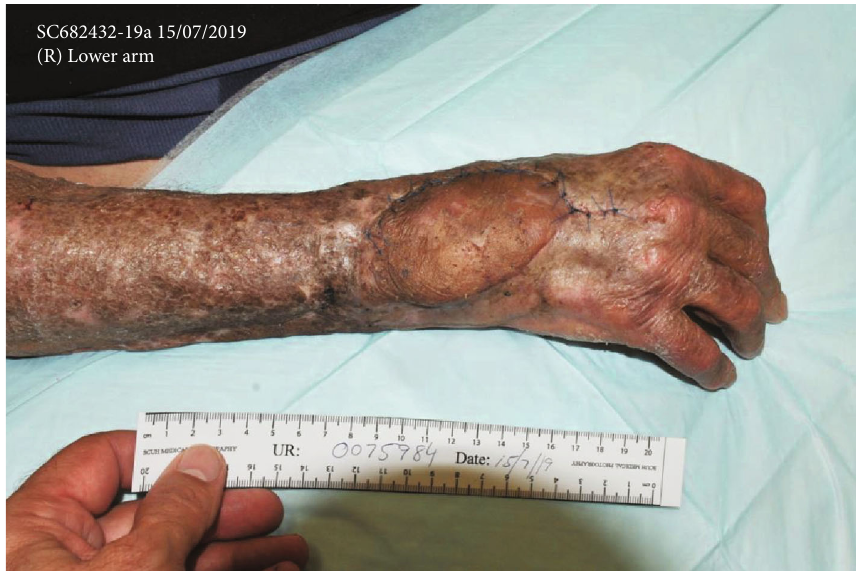
Figure 6: Clinical photograph of the right hand, post wrist